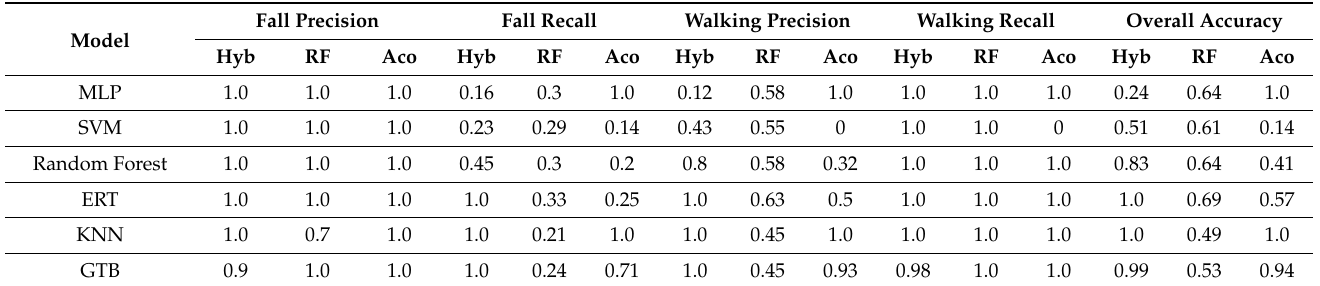
Table 5. Precision, recall, and overall accuracy of models for recorded data in the new room (Hyb: hybrid data; RF: RF data; Aco: acoustic